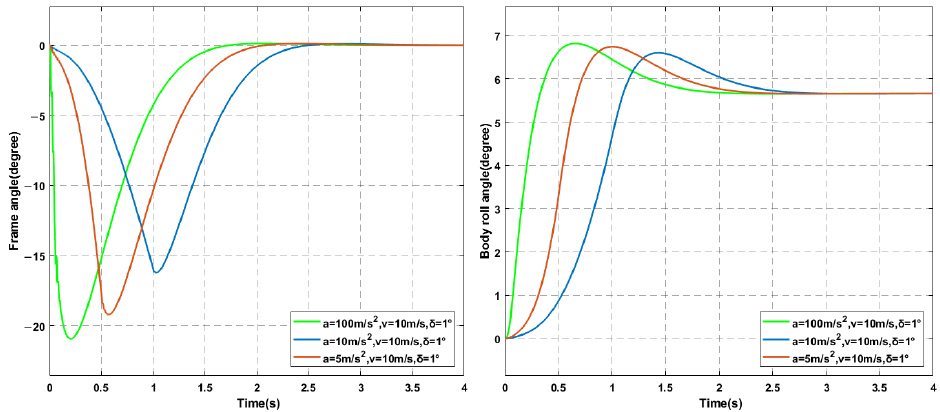
Figure 19. Simulation results: Self-balancing process of vehicle body under different accelerations. Table 6. Gain set of steering control parameters.